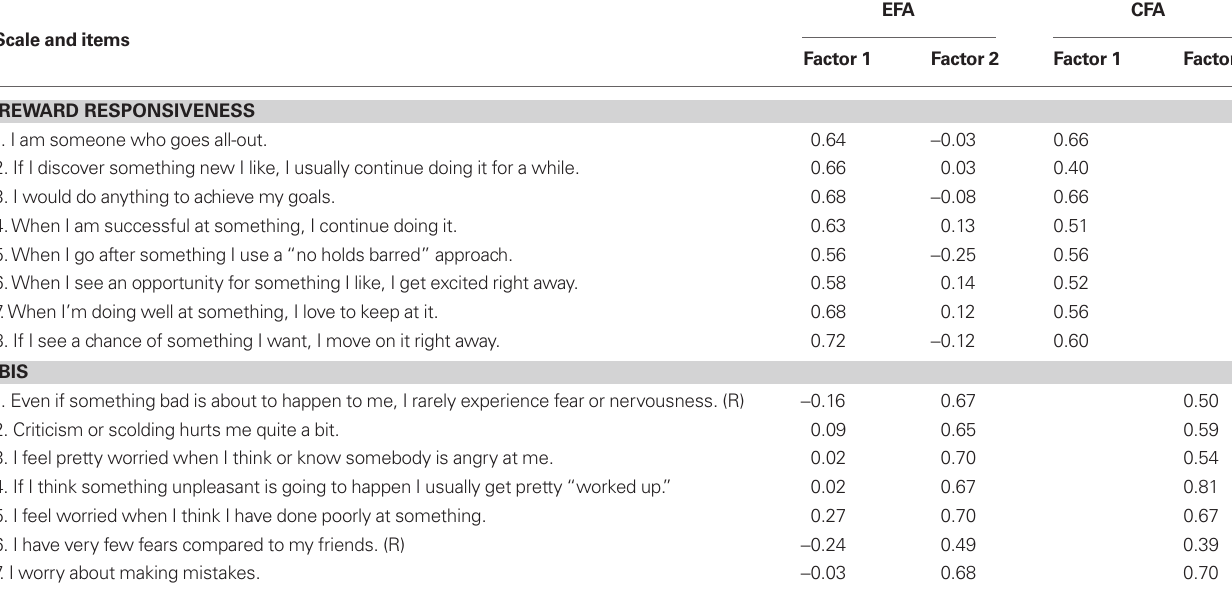
Table 2 | Reward responsiveness and BIS scale items and factor loadings obtained with a joint exploratory factor analysis (Study 1) and confirmatory factor analysis (Study